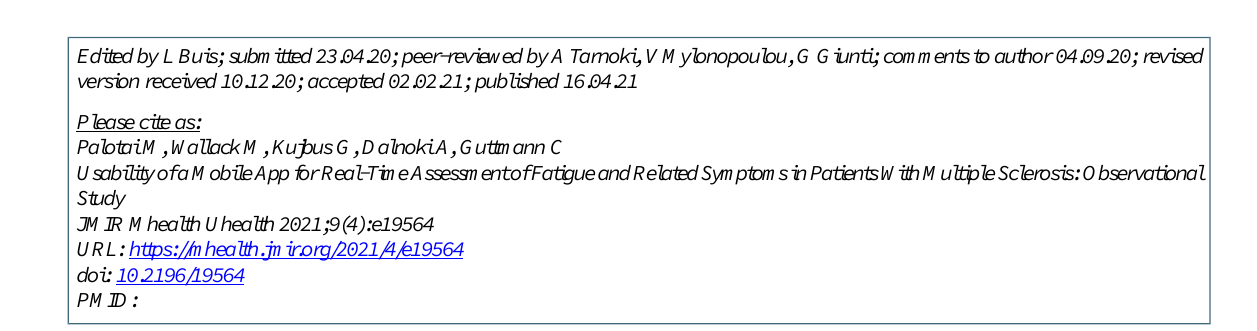
VAS: Visual Analogue